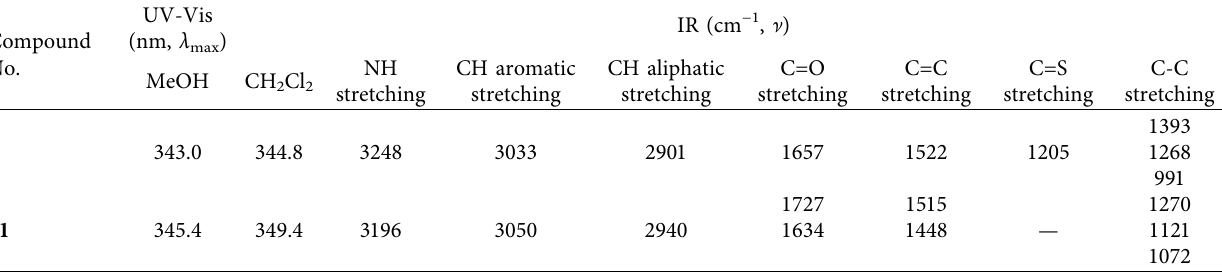
Table 2: UV-Vis and IR spectra of compounds 3 and 11